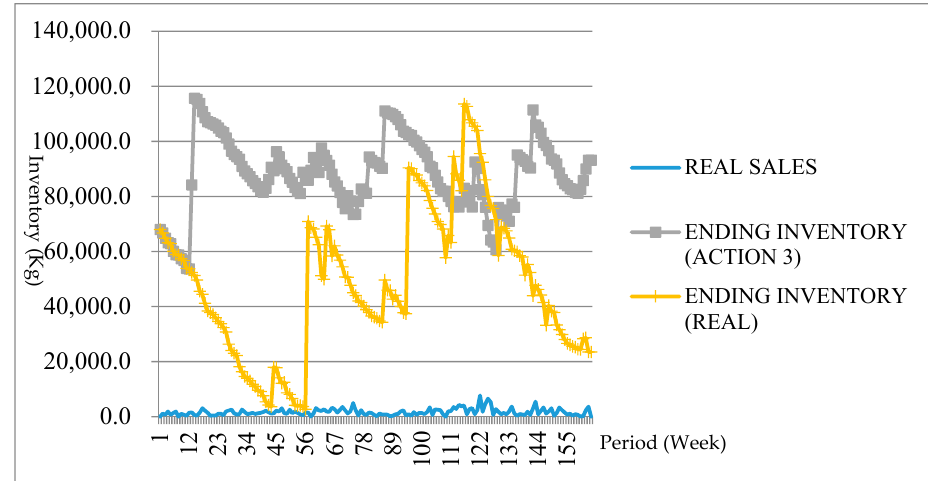
Figure A3. Inventory charts of action 3.